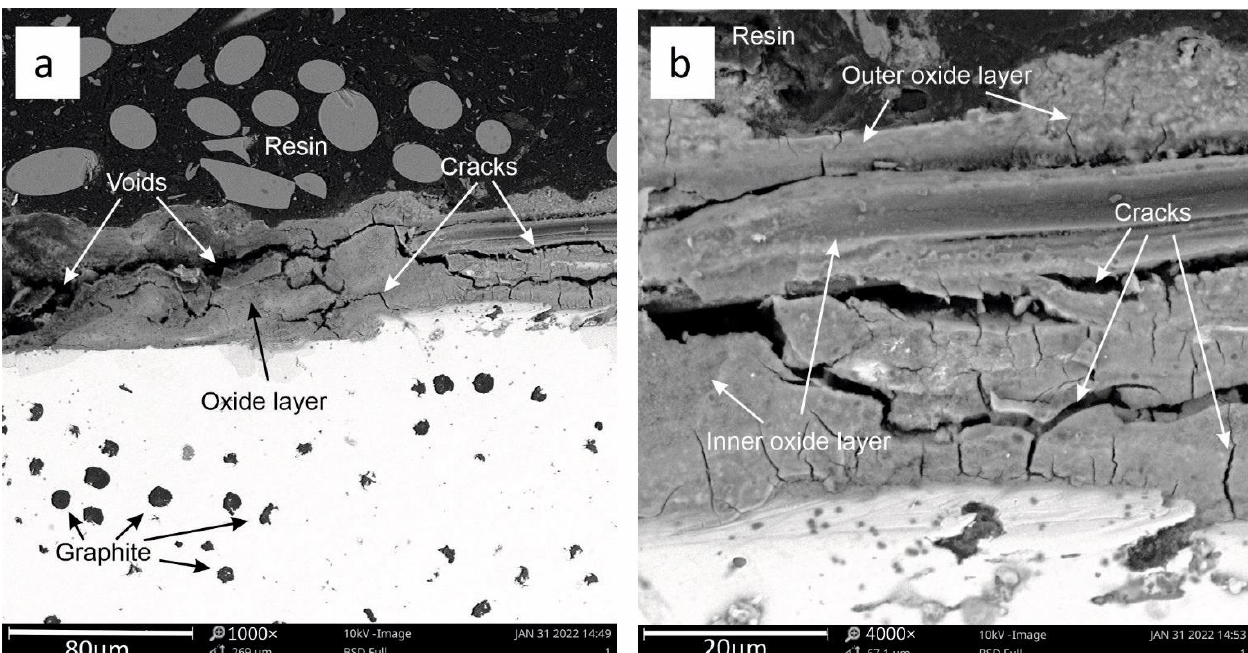
Figure 9. View of the oxide layer after three heating cycles ( a ) for sample 1. Detailed description of the oxide layer ( b ).